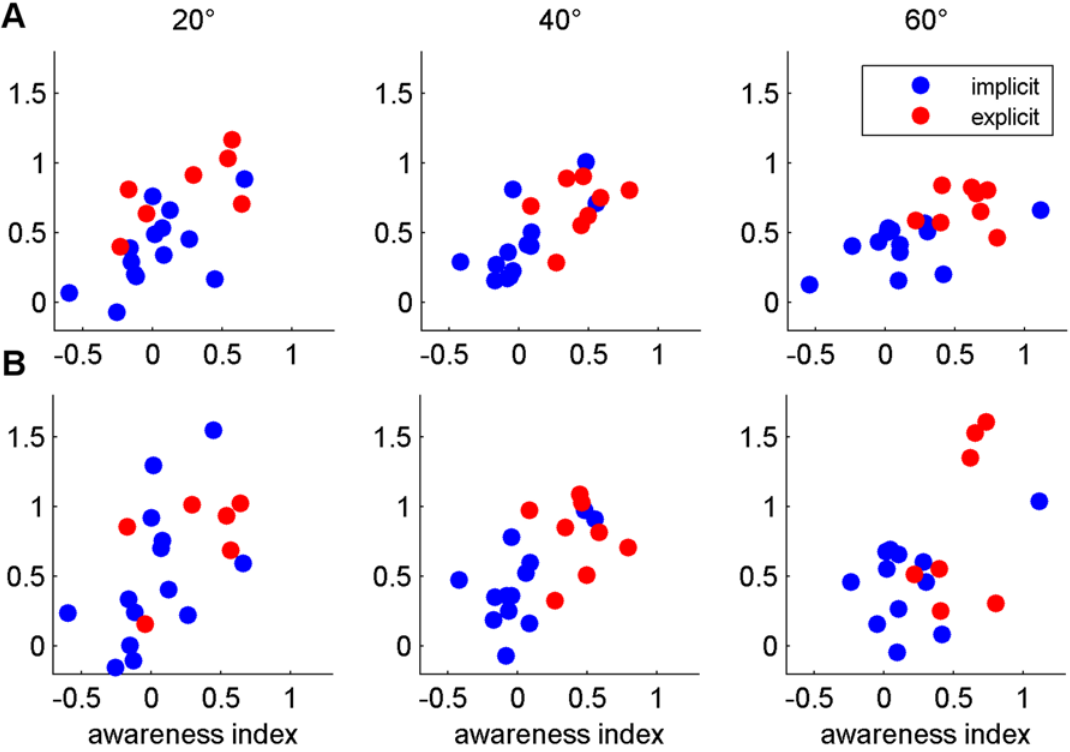
Fig 6. Correlations between awareness and adaptation. Correlations between the awareness indices for each rotation size and the respective adaptation (A) or clamp trial index (B). Red dots indicate explicit and blue ones implicit participants.